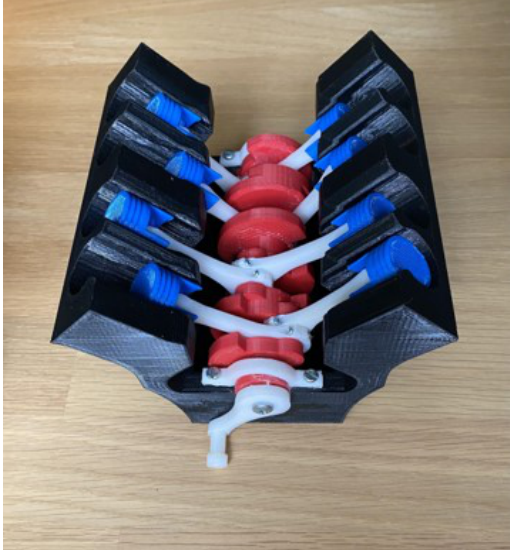
Figure 7. Construction of a V8 engine model by 3D printing at University of Ferrara [39].